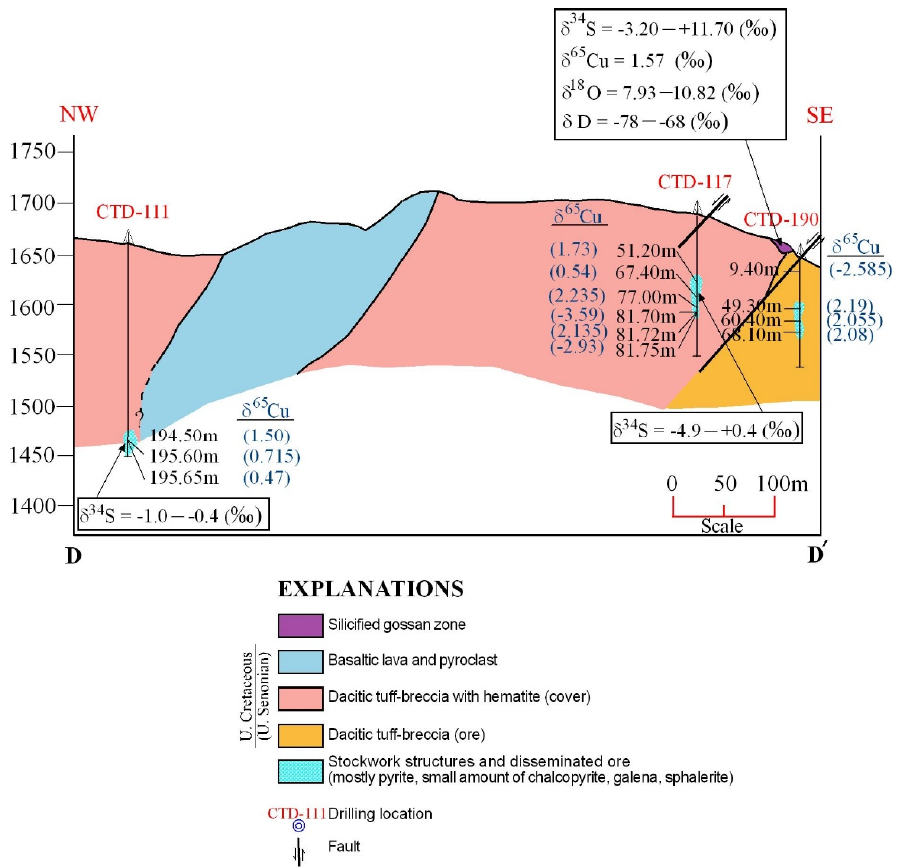
Figure 15. D–D’ cross section along drill cores CTD-111, CTD-117, and CTD-190 with reference to Figure 3. δ 18 O, δ D, δ 3 4 S and δ 65 Cu, isotope data of samples from drill cores gossan zone of Cerattepe VMSD, Isotope data are from Tables 2–4